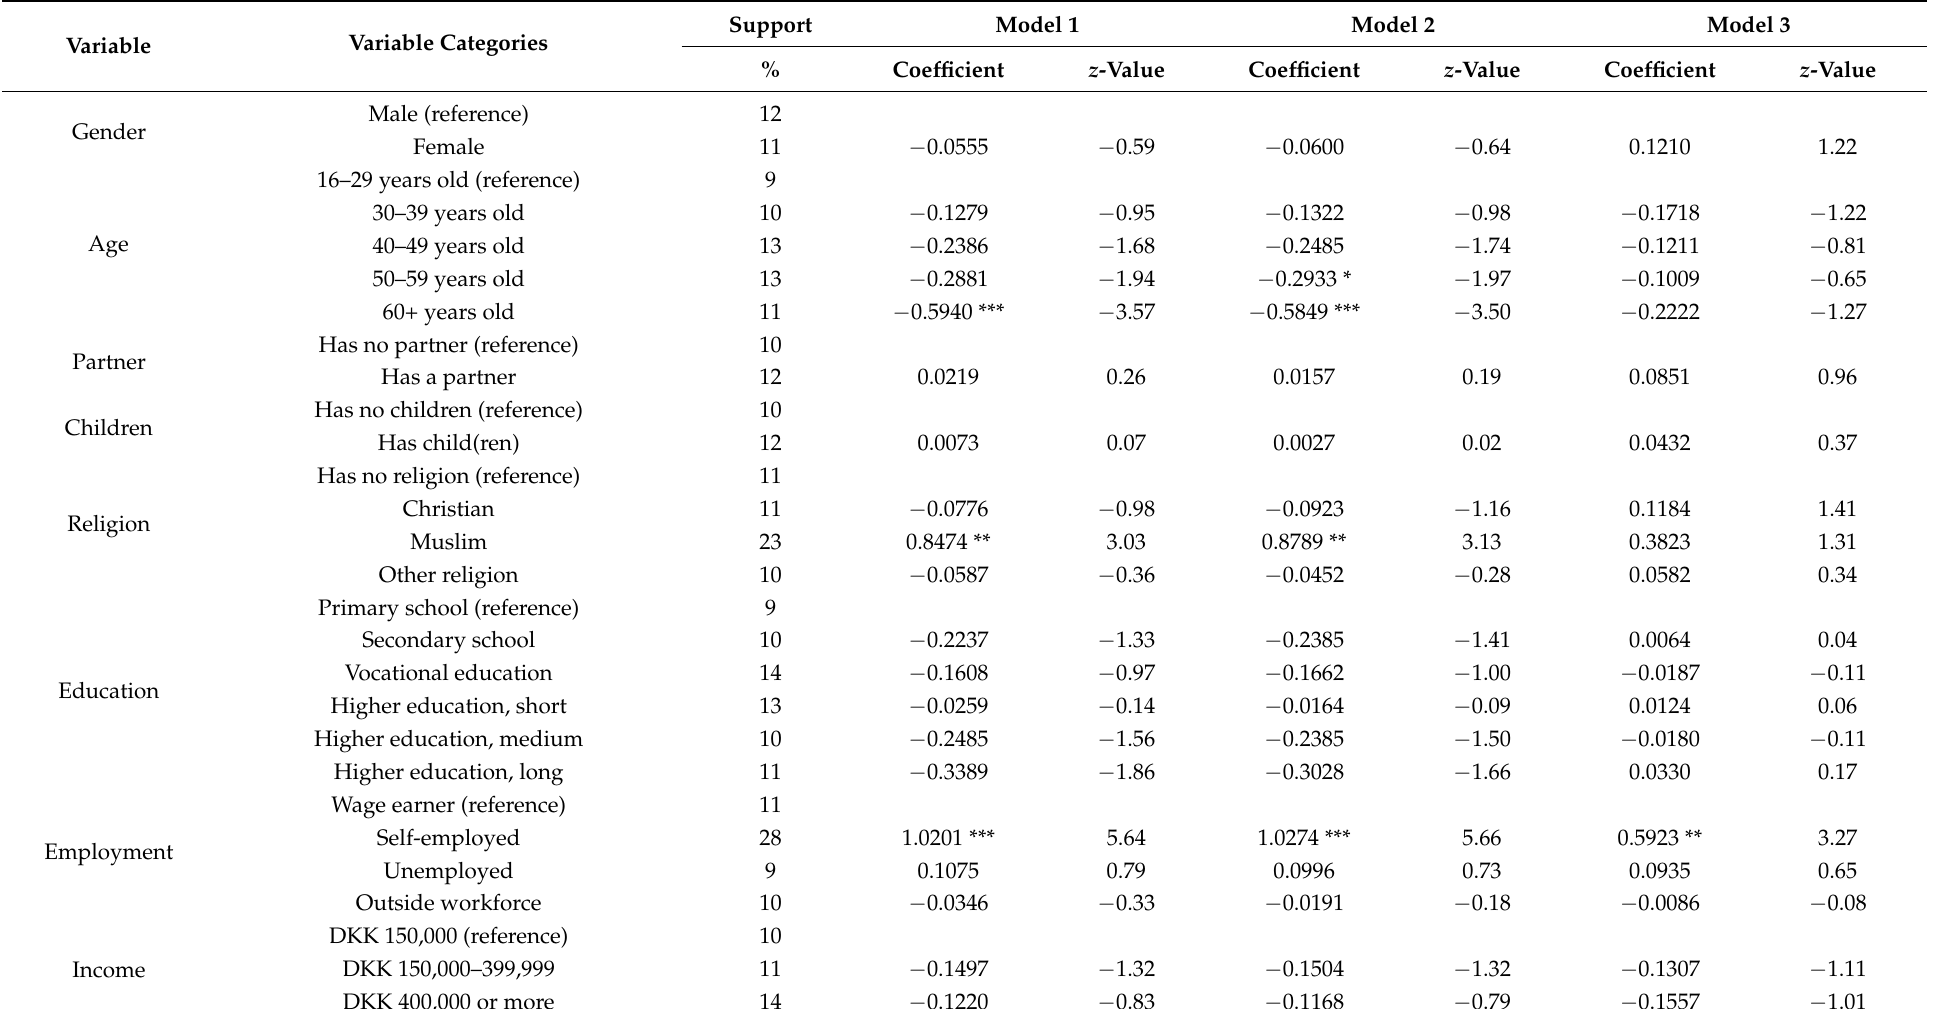
Table 4. Support of demonstrations against the COVID-19 lockdown measures. Ordered logit